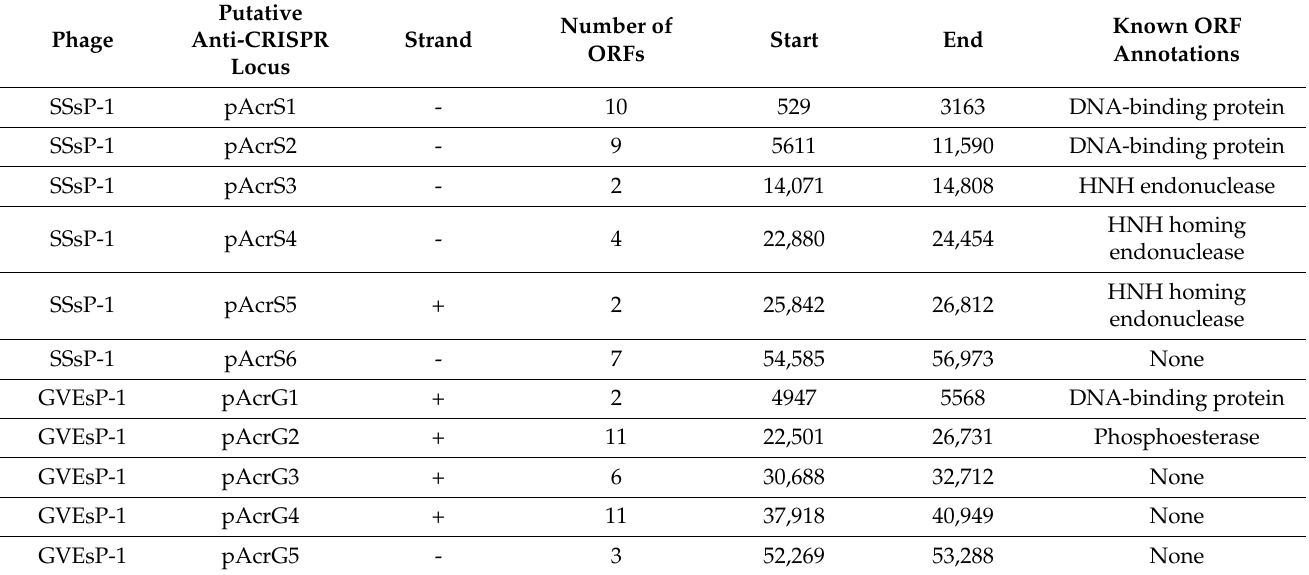
Table 2. The putative anti-CRISPR loci detected by ArcFinder. The described version of the SSsP-1 genome is MZ333457.1; the version of the GVEsP-1 genome is